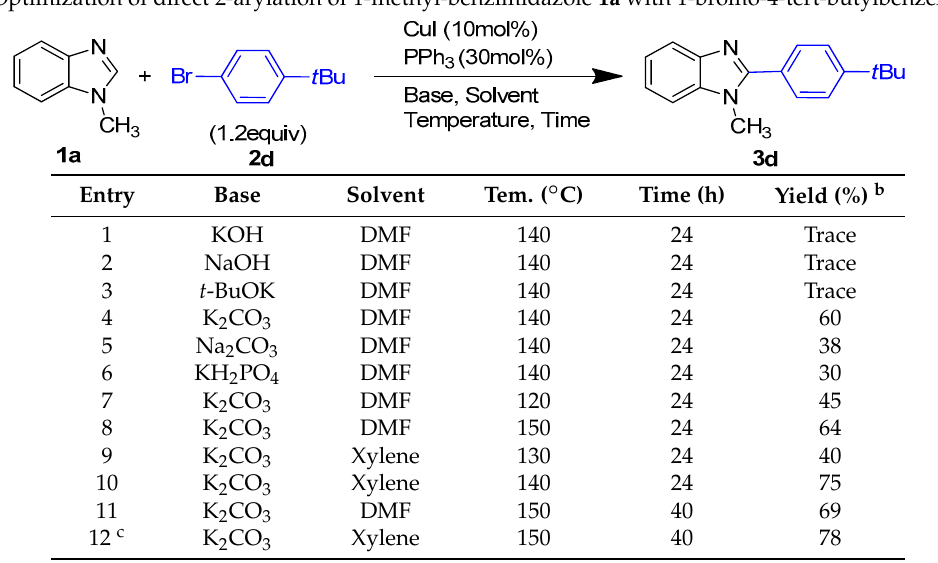
Table 2. Under optimized reaction conditions, the yields of aryl bromides with electron neutral groups, 2-bromonaphthalene ( 2a ), 1-bromonaphthalene ( 2e ), and1-bromo-4- tert -butylbenzene ( 2d ), were